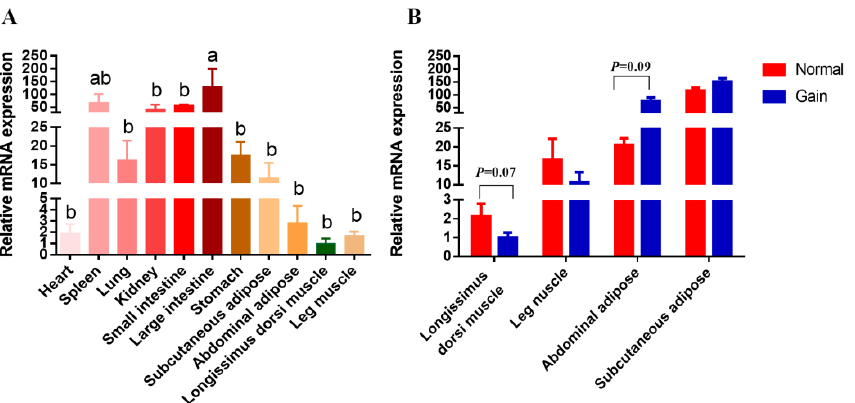
Figure 2. Comparison analysis of SNX29 gene expression levels among different tissues ( A ) and different CNV genotypes ( B ) in Xiangdong black goats. ( A ) The SNX29 gene mRNA expression profile in 11 different tissues of three adult female XDB goats. The relative mRNA expression level of SNX2 9 gene were calculated by 2 − △△ Ct method. The GAPDH was used as the internal reference gene. Different letters (a, b) within the same row represent significant differences among the three groups. ( B ) Comparison of SNX29 gene expression levels among different SNX29 CNV genotypes in abdominal adipose, subcutaneous adipose, longissimus dorsi muscle, and leg muscle tissues of 30 female XDB